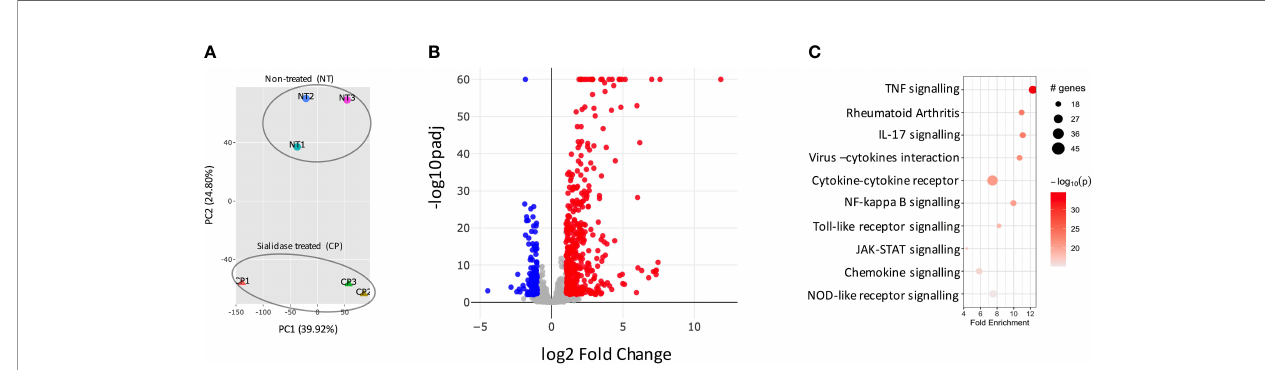
FIGURE 3 | Sialidase-treated SFs show an in fl ammatory transcriptomic pro fi le. SFs from naive mice were cultured and expanded ex vivo , RNA was isolated from non-treated control (NT) and C. perfringens sialidase treated (CP) SFs, then subjected to bulk RNA-Seq (75bp paired-end, 30M reads, n = 3). (A) Principal component analysis (PCA). (B) All detected genes are plotted as a volcano plot. Genes that passed a threshold of padj < 0.01 and |foldChange| > 2 are considered differentially expressed genes (DEGs), comparing sialidase-treated and non-treated SFs. Colour code, red: upregulated, blue: downregulated, in CP treatment. (C) Upregulated genes in sialidase treatment identi fi ed in (B) were used to perform KEGG pathway enrichment analysis. KEGG pathways are plotted in bubble chart with fold enrichment on x-axis and -log10 p-value on the coloured scale. The size of bubble is proportional to the number of DEGs in the given